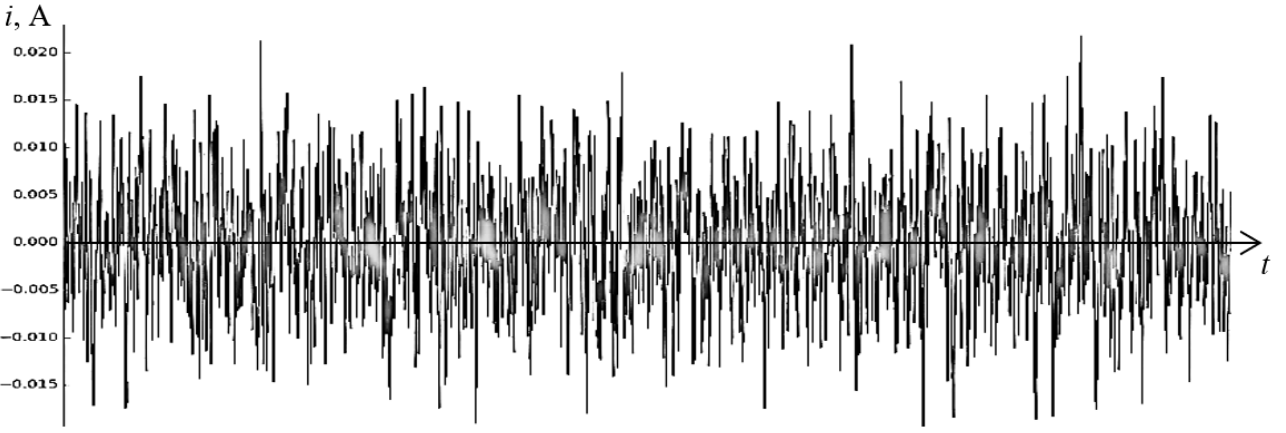
Figure 5. The semiconductor ring equivalent circuit. The idea of the semiconductor ring shown in Figure 5 belongs to the MAI master Alexander Bindiman. In this case, it can be assumed that in such a looped semiconductor, an average direct current should circulate (see Figure 6), approximately equal to the standard deviation of thermal noise. Figure 6. Expected thermal noise in a semiconductor ring.